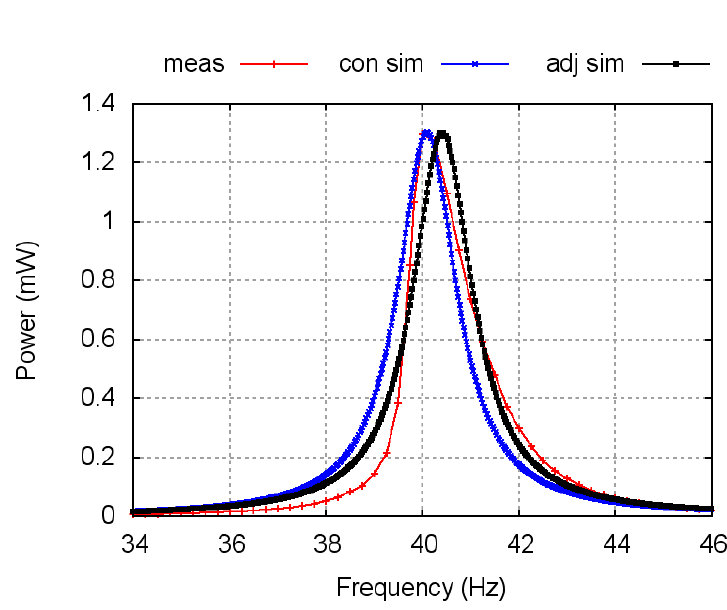
Figure 2. Simulation (sim) of the conventional (con) and adjusted (adj) lumped element model compared to the measurements (meas).